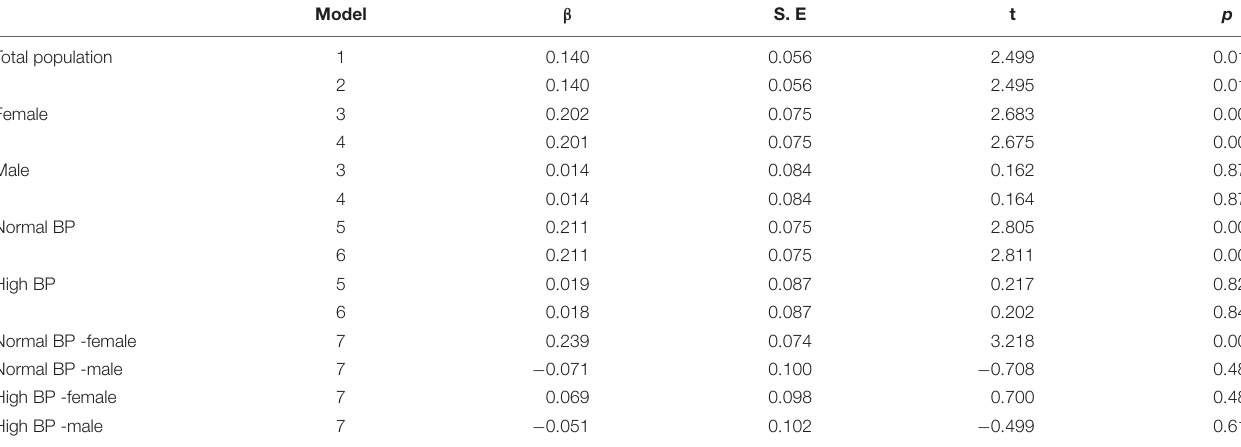
TABLE 3 | Multiple linear regression of LAP levels and rate of change in MMSE score. Model